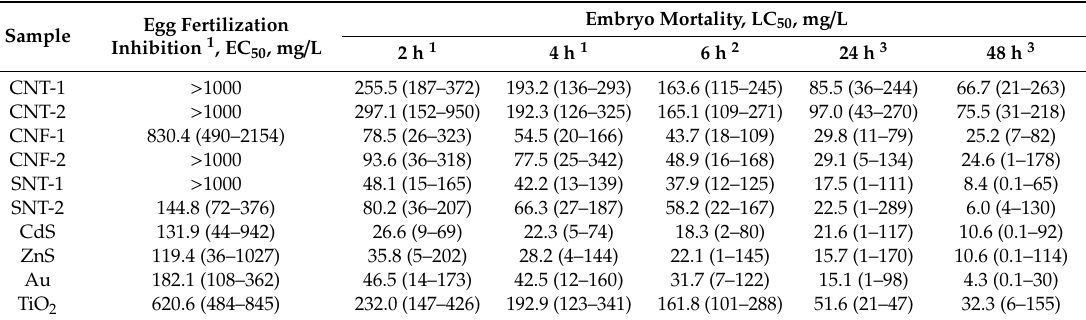
Table 2. The mean calculated EC 50 values of the inhibition of egg fertilization and the mean calculated LC 50 values of embryo mortality of the sea urchin S. intermedius . Egg Fertilization Sample Inhibition 1 , EC 50 , mg /